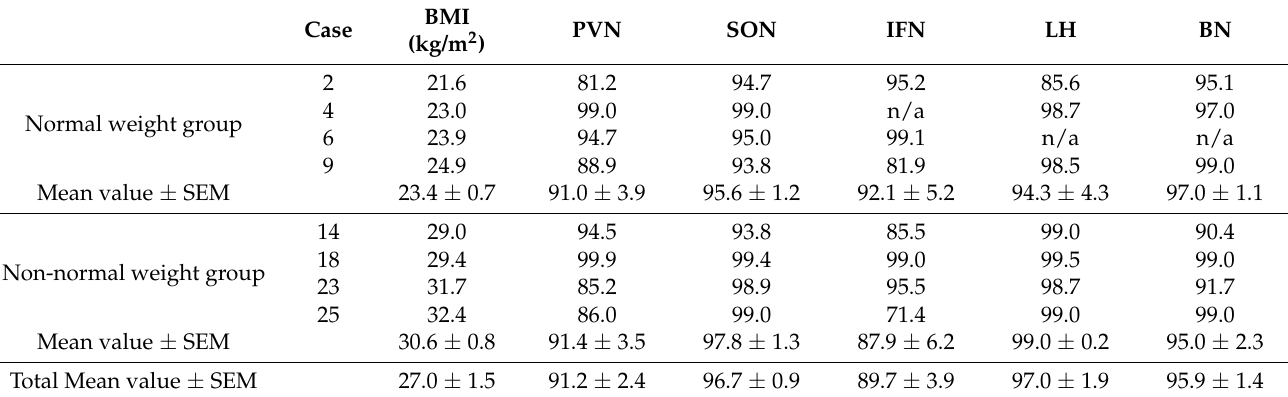
Table 4. Double immunofluorescence analysis of GLP-1-receptor-immunoreactive neurons colo- calizing with NUCB2/nesfatin-1 in human hypothalamus. Numbers denote the percentage of GLP-1-receptor-immunoreactive neurons colocalized with NUCB2/nesfatin-1 (%).